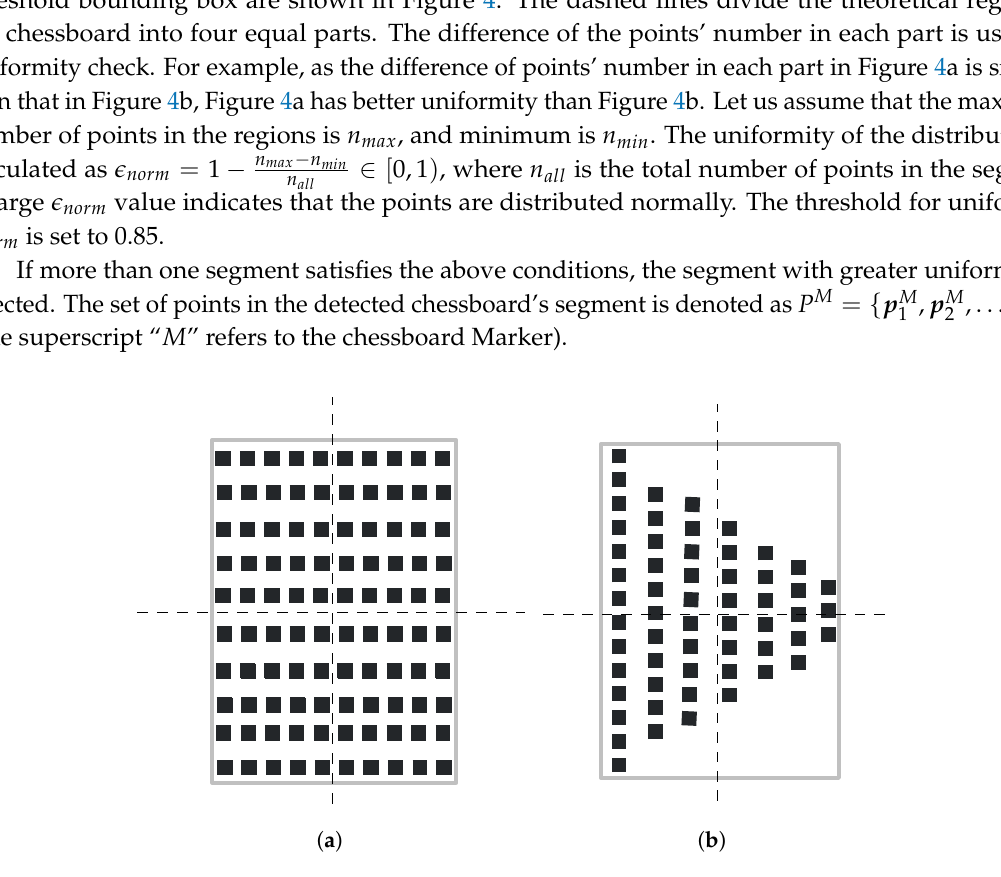
Figure 4. Uniformity of the points distribution. ( a ) shows an example of the point cloud with better uniformity than ( b